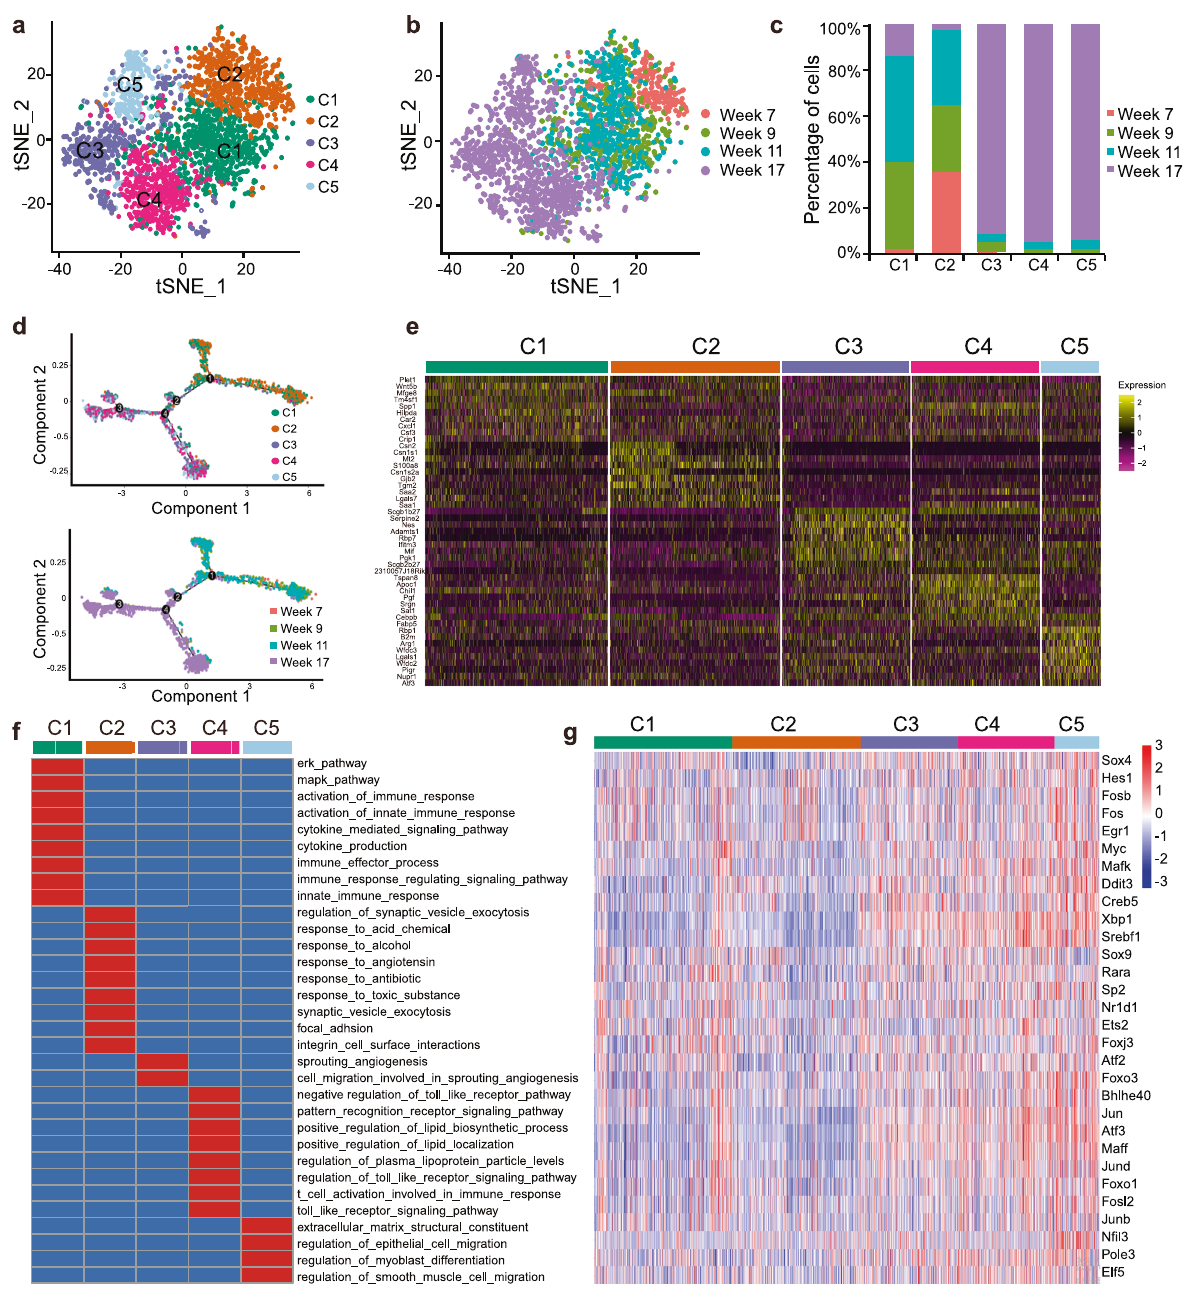
Fig. 5 The heterogeneity of stem-like cells. a , b t-SNE plot demonstrated the separation of sub-clusters C1, C2, C3, C4, and C5 in LuE2 cluster colored by sub-clusters ( a ) and by tumor progression stages ( b ). c A bar-plot depicted the composition of cells from different tumor progression stages in each sub-cluster. d Pseudo-time analysis showed the single-cell trajectories for LuE2 cluster colored by sub-clusters (top panel) and tumor progression stages (bottom panel). e A heatmap showed the expression pro fi le of marker genes from each sub-cluster. f A heatmap showed the function enrichment for each sub-cluster. Signi fi cant enrichment was colored by red. g A heatmap of regulon scores from SCENIC (Single Cell rEgulatory Network Inference and Clustering) analysis. Rows, Individual regulons. Columns, cells organized according to re-clustering of cluster Library preparation and sequencing for human sample The fresh tumor tissue was stored in the GEXSCOPE TM Tissue Preservation Solution (Singleron) and transported to the Singleron lab on ice as soon as possible. The specimens were washed with Hanks Balanced Salt Solution (HBSS) for 3 times and minced into 1 – 2 mm pieces. Then the tissue pieces were digested with 2 ml GEXSCOPE TM Tissue Dissociation Solution (Singleron) at 37 °C for 15 min in 15 ml centrifuge tube with sustained agitation. After digestion, using 40-micron sterile strainers to fi lter the